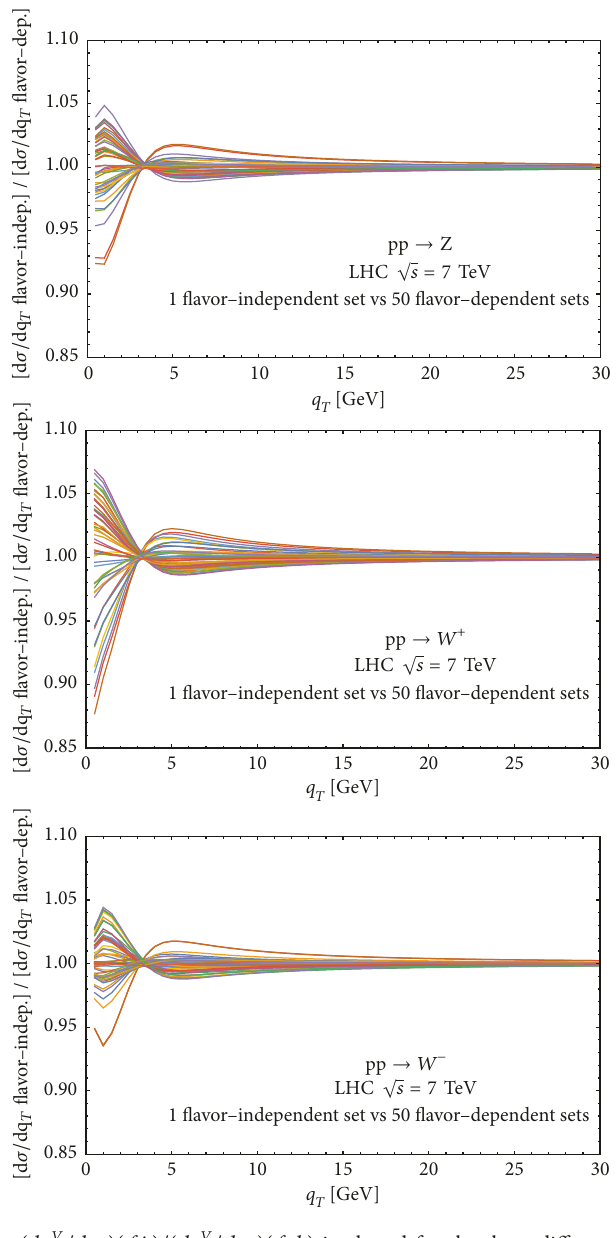
Figure 3: In these figures the ratio (𝑑𝜎 𝑉 /𝑑𝑞 𝑇 )(𝑓.𝑖.)/(𝑑𝜎 𝑉 /𝑑𝑞 𝑇 )(𝑓.𝑑.) is plotted for the three different electroweak bosons ( 𝑉 = 𝑍 , 𝑊 + , 𝑊 − , respectively), with a single set of flavour-independent (f.i.) nonperturbative parameters in the transverse part of the TMD PDFs and 50 different flavour-dependent (f.d.) sets of the same parameters. The analysis has been performed at NLL [11, 13]. The values of the nonperturbative parameters have been chosen from the results in [14,